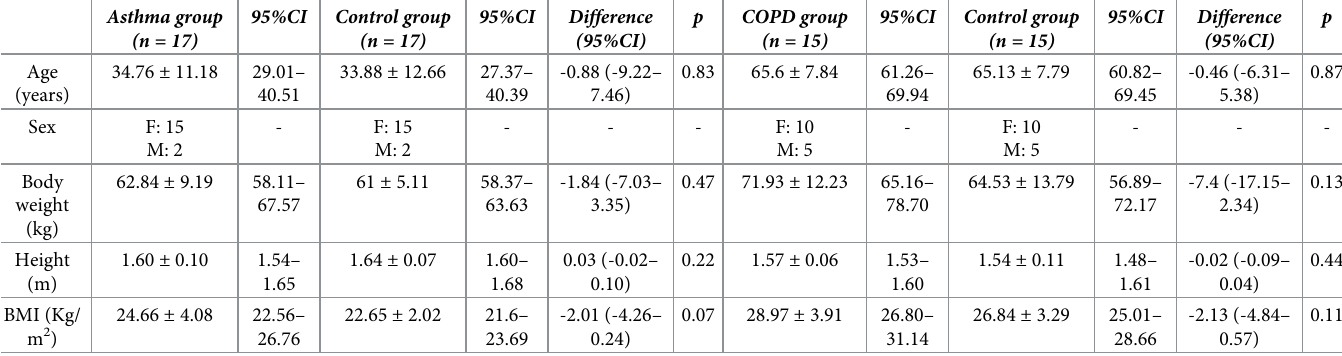
Table 1. Anthropometric characteristics of the